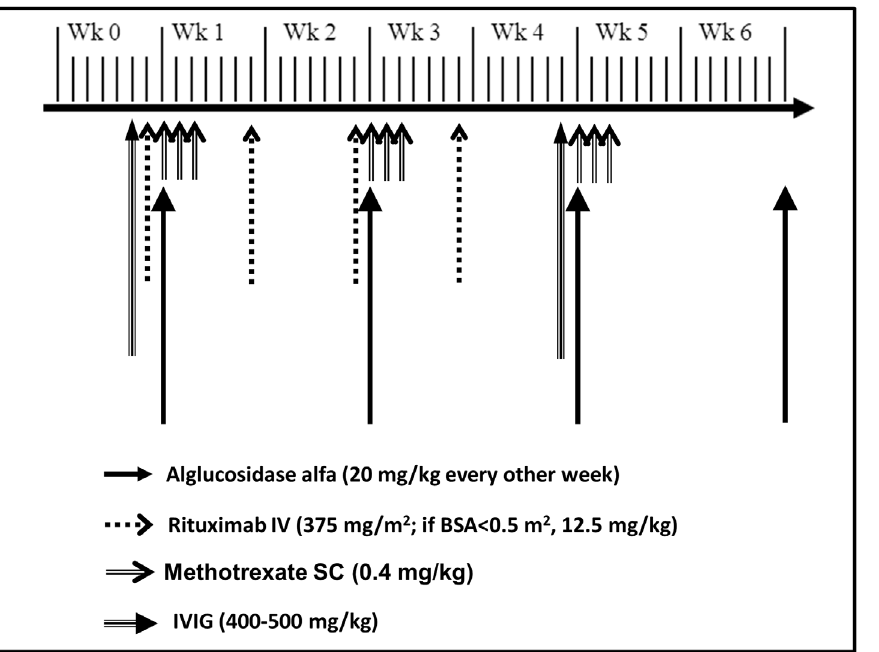
Figure 3. ITI treatment regimen which includes rituximab, methotrexate and intravenous immunoglobulin (IVIG). This short course of ITI regimen (5 weeks) needs to be started together with the first dose of ERT. IVIG is administered on a monthly basis for a period of 5–6 months.